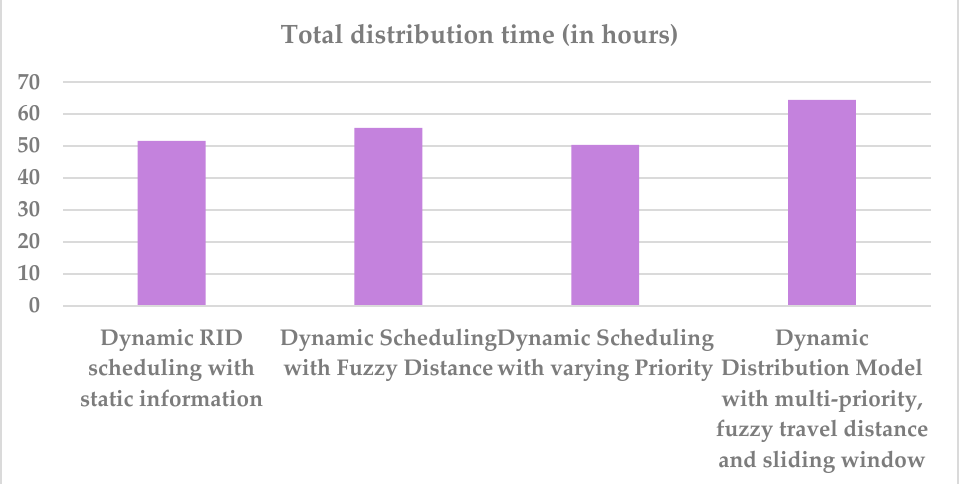
Figure 4. Distribution time plots of different dynamic RID Models.